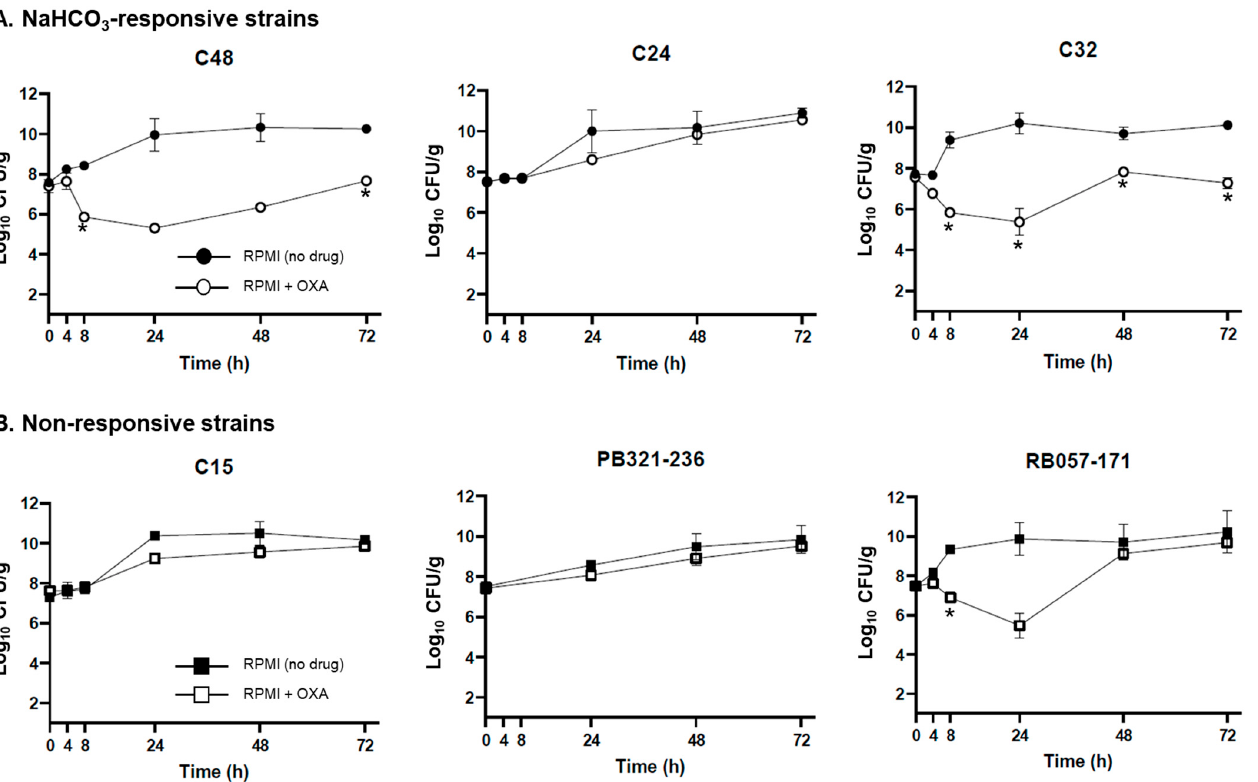
Figure 1. Simulated endocarditis vegetation (SEV) tissue burdens following OXA treatment of ( A ) NaHCO 3 -responsive or ( B ) Nonresponsive MRSA. SEVs containing MRSA were exposed to RPMI tissue culture medium with or without OXA exposure at doses that simulate human serum PK/PD. Vegetations were quantitatively cultured for MRSA CFU/g at 0, 4, 8, 24, 48, and 72 h time points. Statistics were performed on the CFU/g present in untreated samples versus OXA treatment at the indicated time point by a Student’s t -test (* p < 0.05).